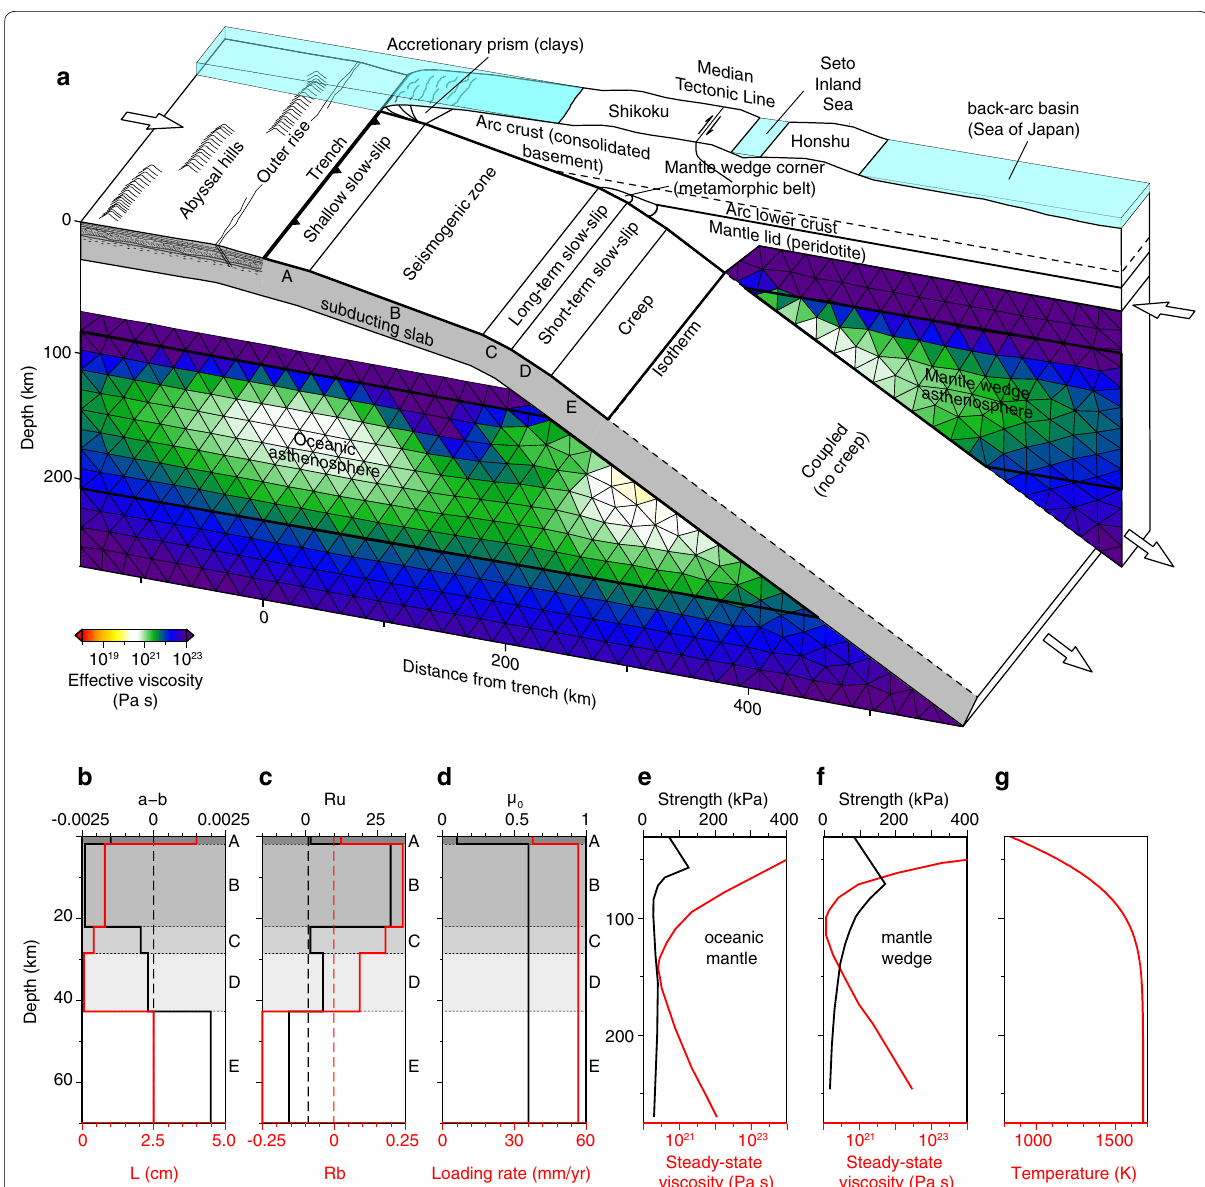
Fig. 2 Conceptual model and physical parameters for the down-dip segmentation of the megathrust and the ductile substrate. a Synoptic look at the relationship between brittle and ductile processes with a subduction zone geometry. The megathrust is segmented into the accretionary prism (segment A), seismogenic zone (segment B), metamorphic belt (segment C), mantle lid (segment D), and mantle wedge (segment E). The friction properties of these regions are controlled by the thermo-mechanical properties at the plate interface. The brittle–ductile transition occurs seaward of the volcanic arc. Corner flow in the mantle wedge starts landward of this boundary, in the mantle wedge asthenosphere. b Friction parameters a − b and L of segments A to E, and c corresponding R u and R b numbers. d Static friction coefficient and loading rate along the megathrust. e Rheological parameters of the oceanic asthenosphere at steady state. f Rheological parameters of the mantle wedge at steady state. g Thermal gradient in the upper